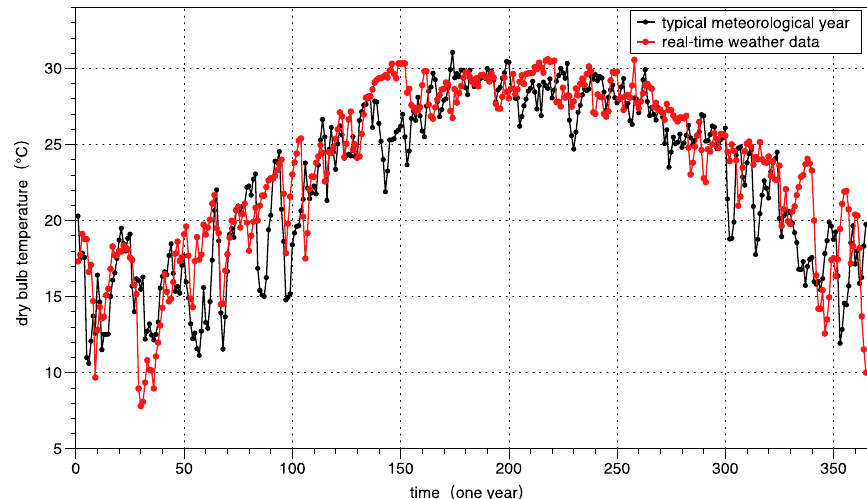
Figure 4. Comparison of actual meteorological year and typical meteorological year.